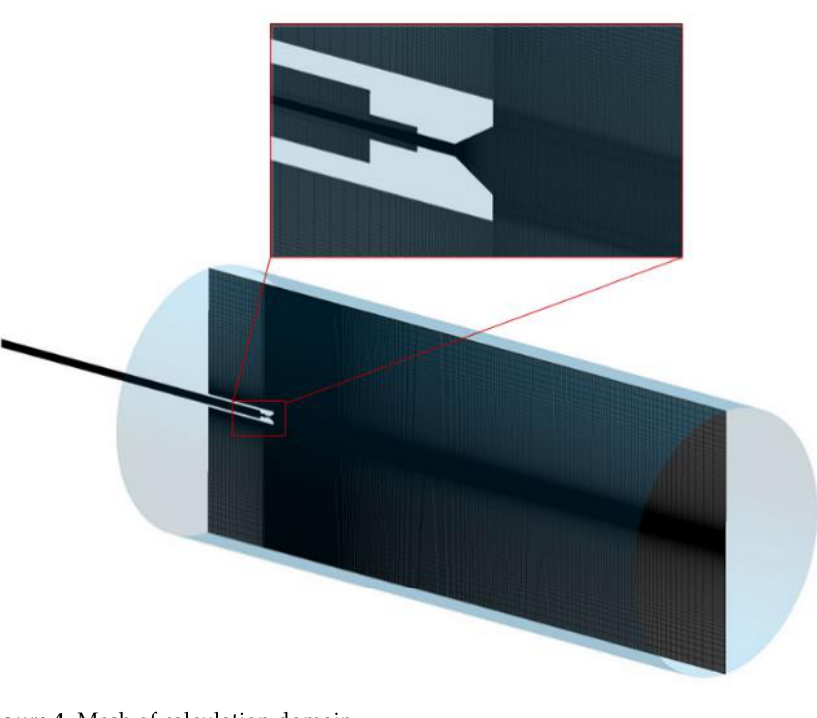
Figure 4. Mesh of calculation